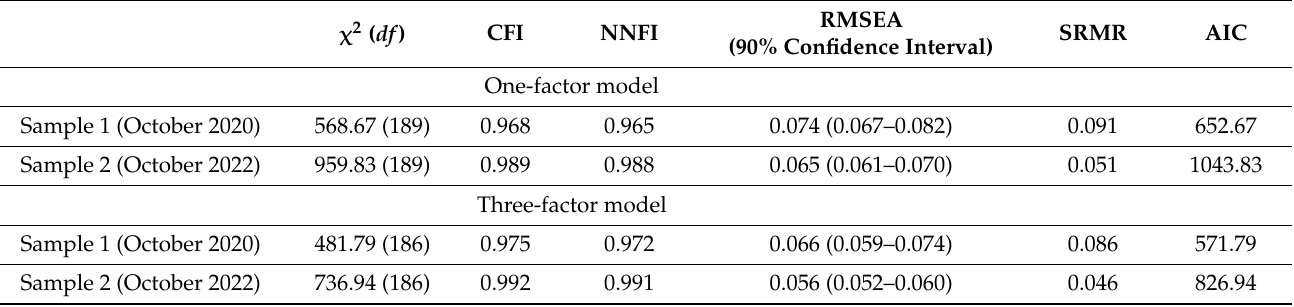
Table 3. Model fit of the different factor structures.